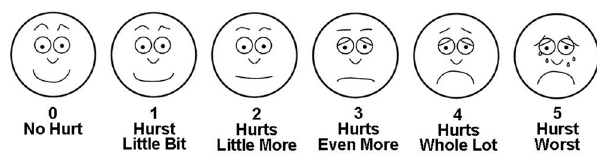
Figure 1 - Wong-Baker FACES Pain Rating Scale